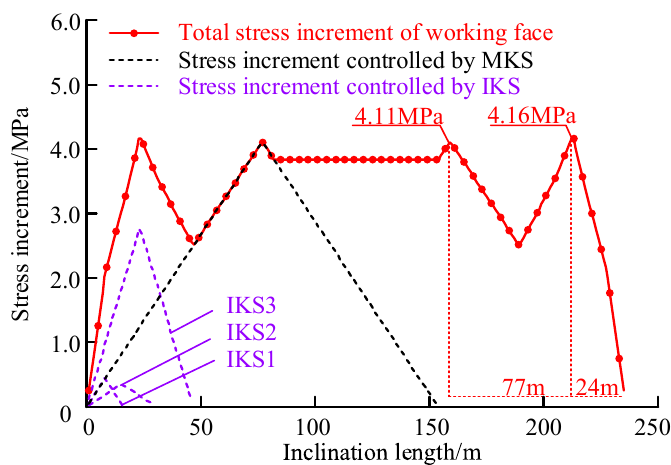
Figure 9. Stress increment distribution map of isolated working face. its stress increment shape is in the form of the “saddle” shape. The total stress increment curve can be divided into four parts. Combined with the stress increment curves of four key strata on one side of the working face, peak area 1 is close to the goaf boundary, mainly affected by the inferior key strata 1, 2, and 3. The peak stress of this part is 4.16 MPa, which is 24 m away from the goaf boundary. Peak area 2 is in the middle of the isolated working face, which is affected by the main key strata. The peak point in this area is 77 m away from the goaf associated with the peak stress value of 4.11 MPa. The central area is the superposition part of the stress increment, affected by the main key strata on both sides. The coal seam is under high stress, which is 93.18% of the maximum stress increment. As a result, the large stress increment of the isolated working face before extraction will lead to coal rib spalling and roof damage during the extraction of the working